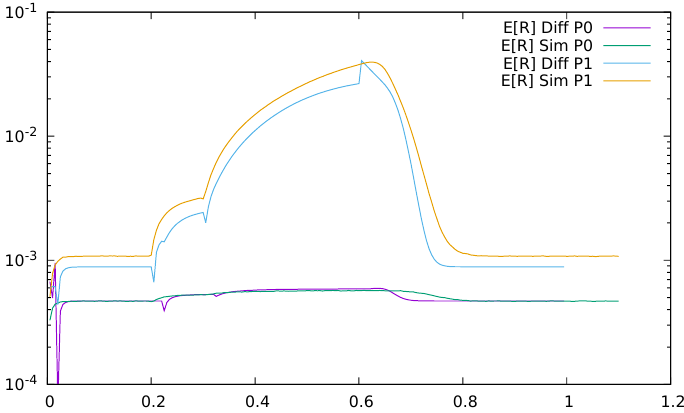
Figure 26. Mean response time at the switch as a function of time, (cid:101) = 0.5, diffusion, and simulation